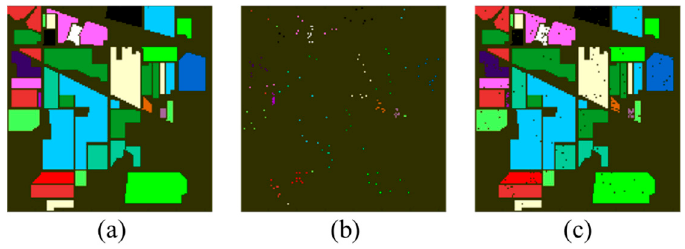
Figure 5. An example of dividing IND PINE dataset into training set and testing set. ( a ) The complete IND PINE dataset. ( b ) Training set generated by randomly picking out 10 samples per class from the complete IND PINE dataset. ( c ) Testing set.